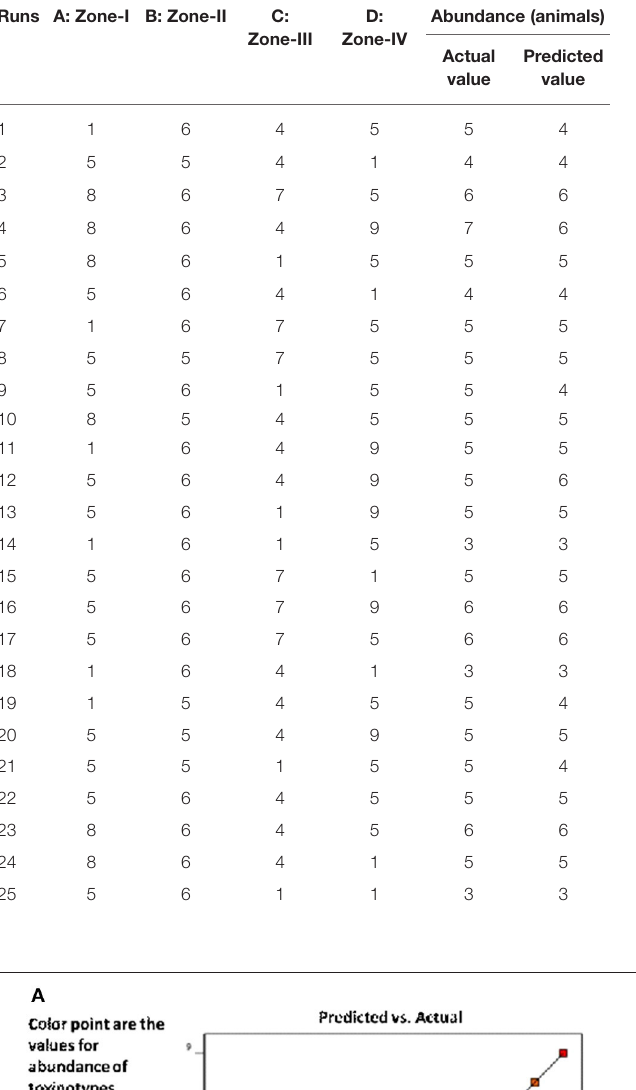
TABLE 8 | Actual and predicted values for C. perfringens toxins in four different zones of Punjab province in Pakistan. Runs A: Zone-I B: Zone-II